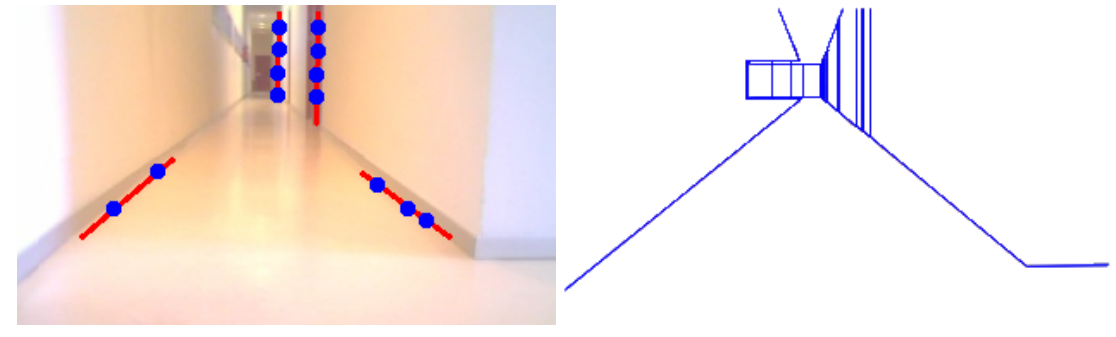
Figure 11. Detected lines in current image and theoretical